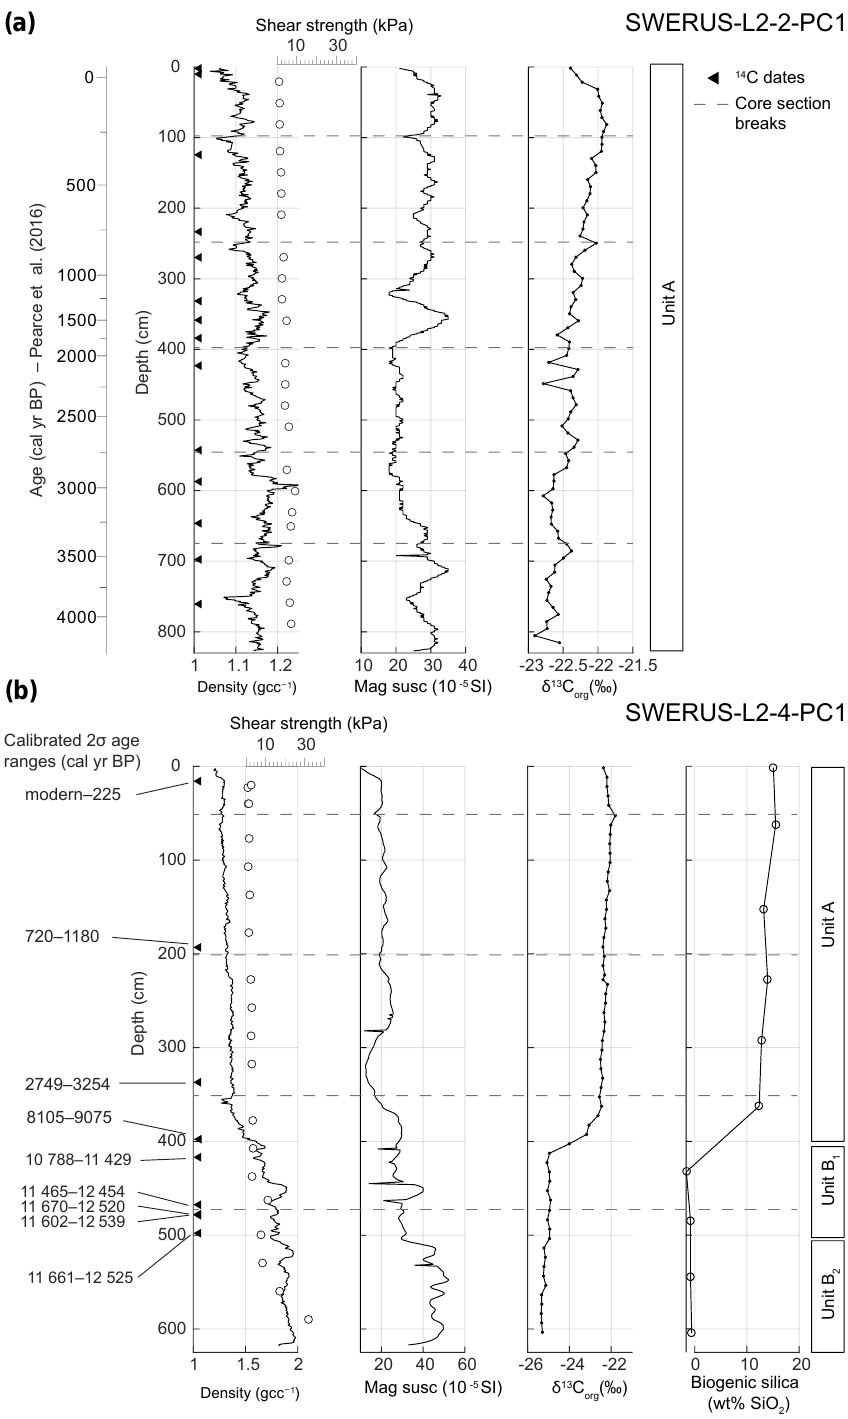
Figure 3. Measured physical properties (density, magnetic susceptibility and undrained shear strength) and geochemical proxy data ( δ 13 C org and biogenic silica) for cores 2-PC1 (a) and 4-PC1 (b) . The black triangles on the depth axes show the positions of AMS radiocarbon dates, and the dashed lines indicate depths of the different sections of the cores. Interpreted lithologic units are shown on the right. All data are presented versus depth in the core and supplemented by an age axis for core 2-PC1 (a) based on the age–depth model presented in Pearce et al. (2017) and 2 σ -calibrated age ranges for core 4-PC1 (b) ; see also Table